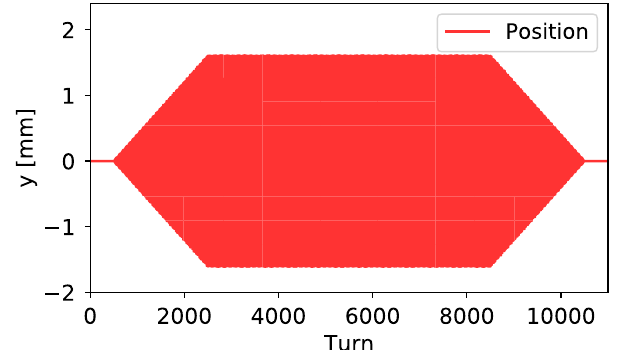
.FIG. 1. Typical ac dipole excitation showing the turn-by-turn amplitude of a particle in the vertical plane. The excitation is similar in the horizontal